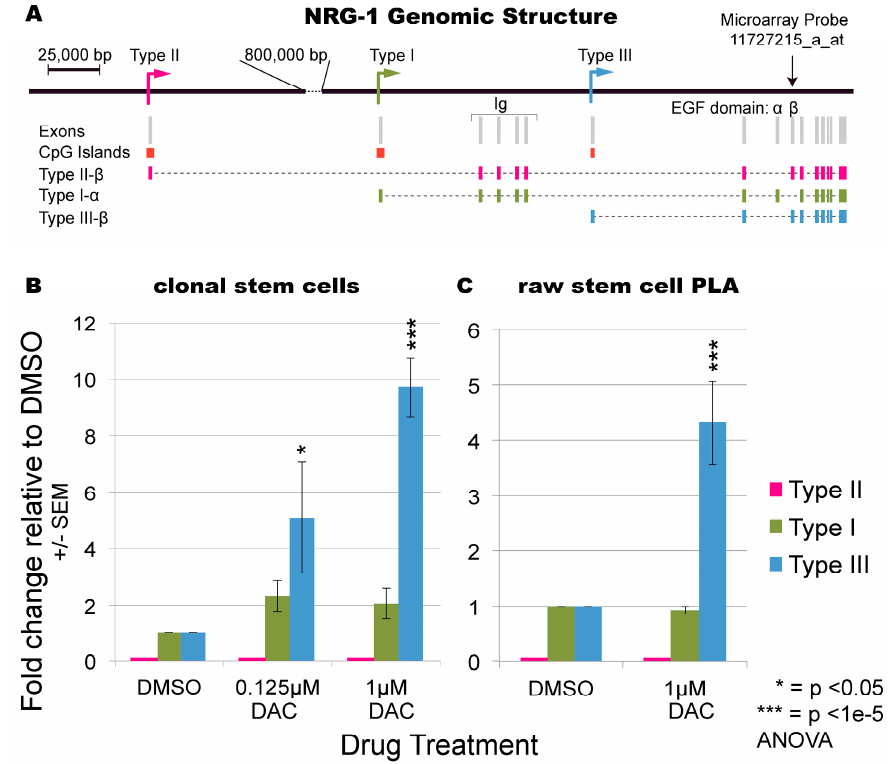
Figure 2. Isoform-specific epigenetic induction of NRG1 expression in primary human ASCs. ( A ) Genomic structure of NRG-1. Types I–III are alternative transcription start sites within